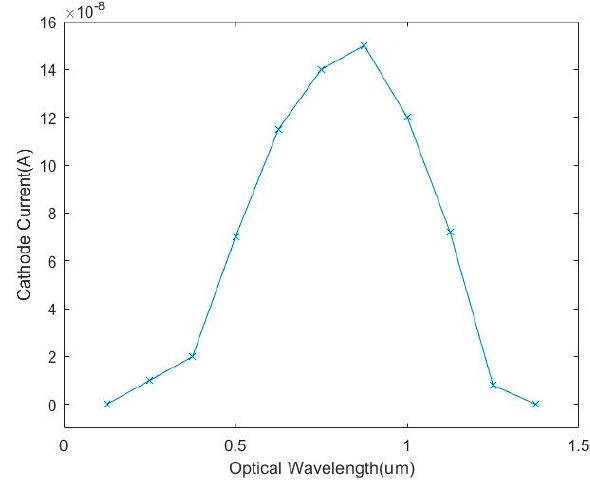
Figure 6. Simulated AC characteristic curve of the PD.